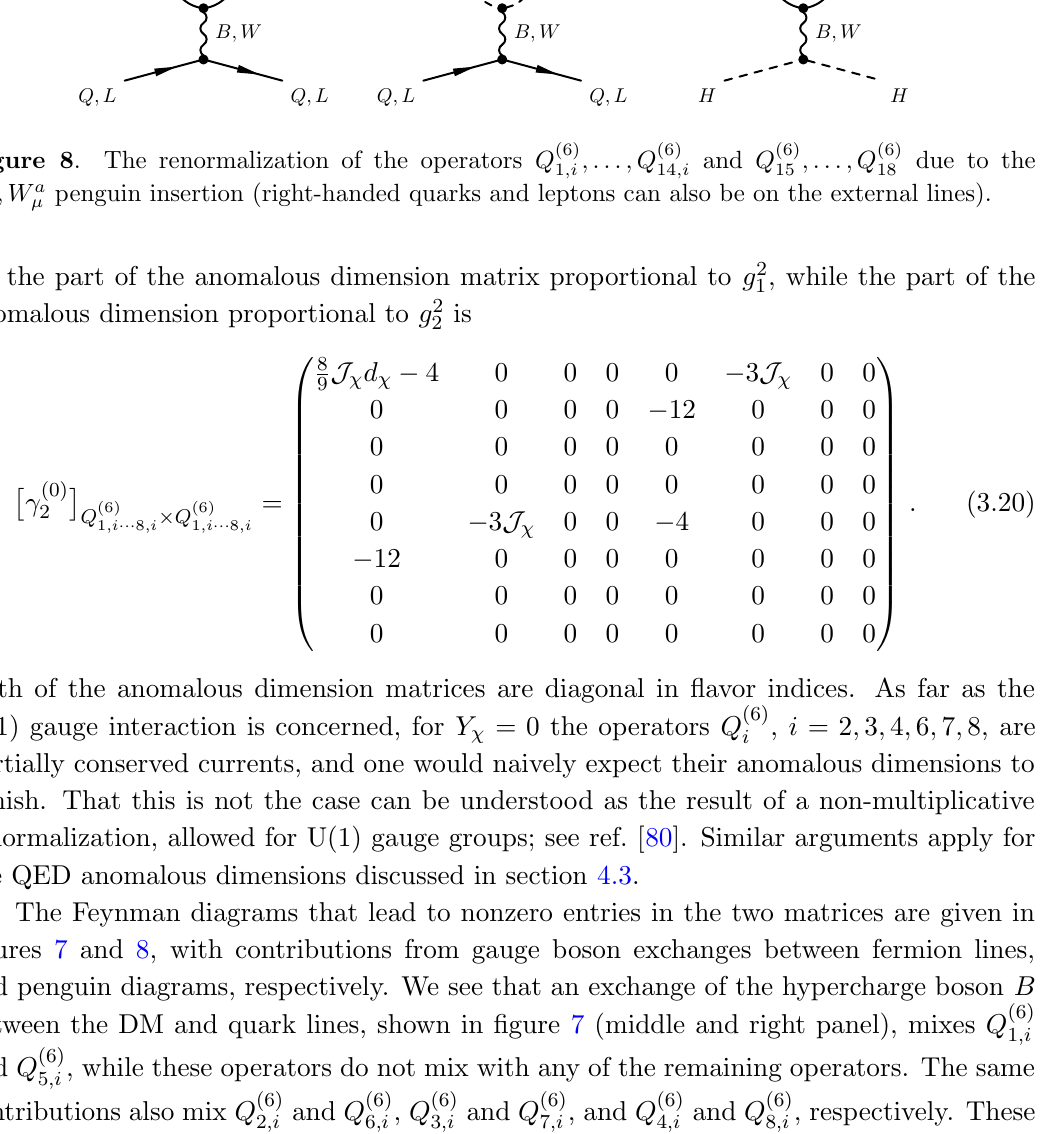
Figure 7 . Sample diagrams for the renormalization of Q (6) of B (cid:22) ; W a at one loop (right-handed quarks and leptons can also be on the external lines). (cid:22)